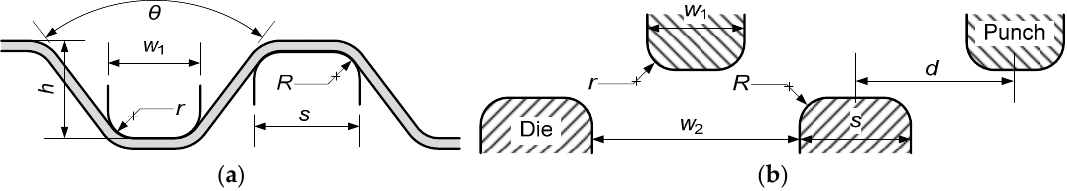
Figure 5. Stamping process used to manufacture BPPs: ( a ) cross-section of the obtained trapezoidal channel with key dimensions; ( b ) cross-section of the tools (punch and die including the main dimensions).